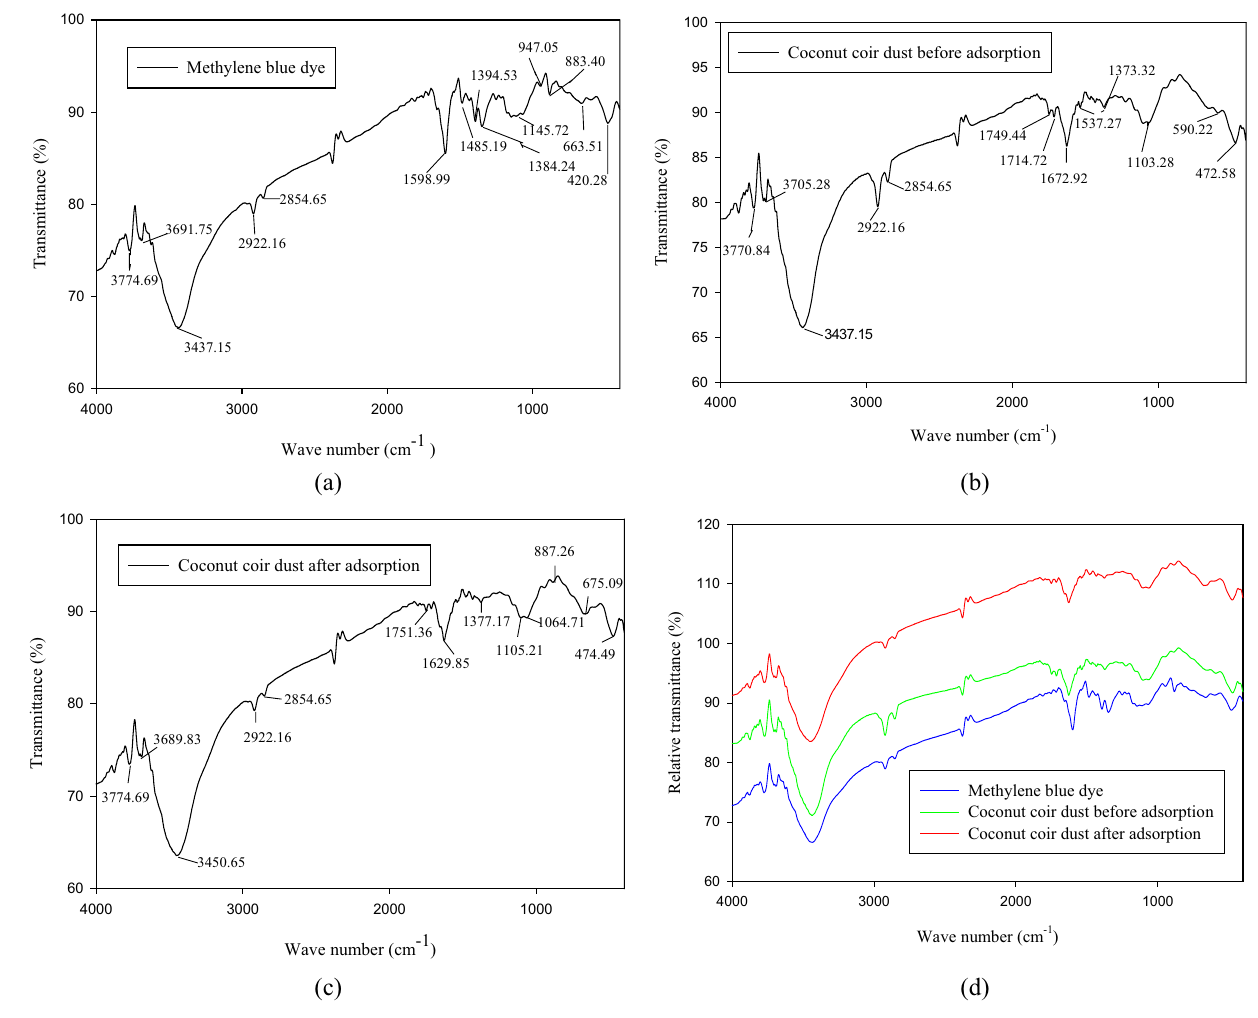
Fig. 9 a FT-IR spectrum of methylene blue dye. b FT-IR spectrum of coconut coir dust before adsorption. c FT-IR spectrum of coconut coir dust after adsorption. d Comparison of FT-IR spectrum of meth- Fig. 10 SEM micrograph of coconut coir dust before adsorp- tion ( a ) and after adsorption, respectively ( b